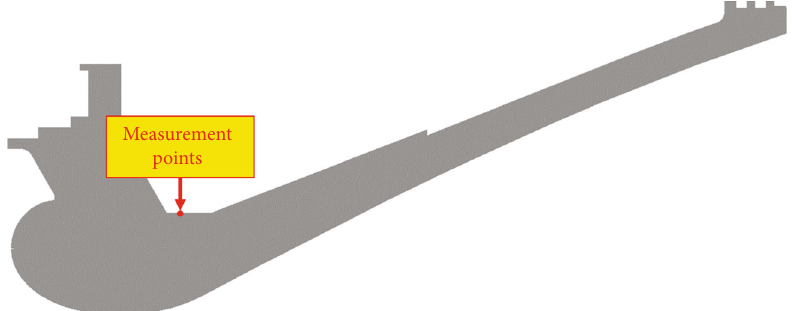
Figure 17: Strain monitoring point in the motor ground test.